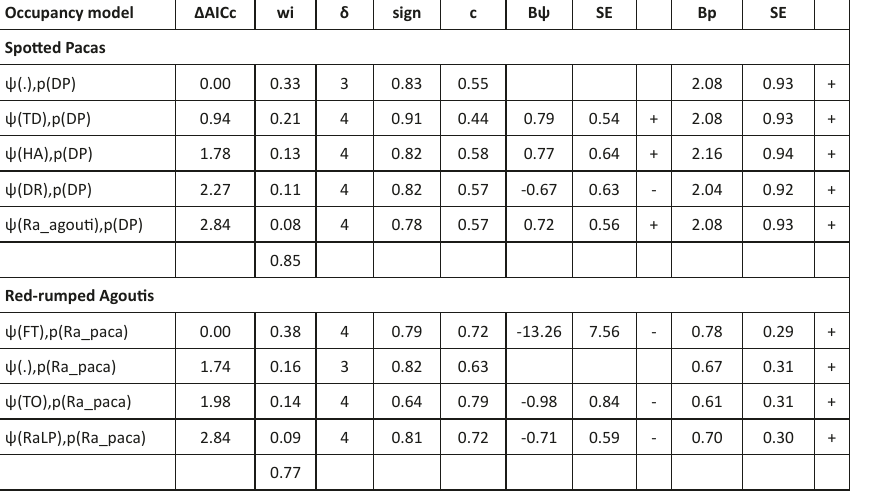
Table 2. Occupancy models used to evaluate the habitat use of the Spotted Paca and Red-rumped Agouti. Reported models are those contributing to more than 70% of the total explanation of all models for each species. Occupancy model